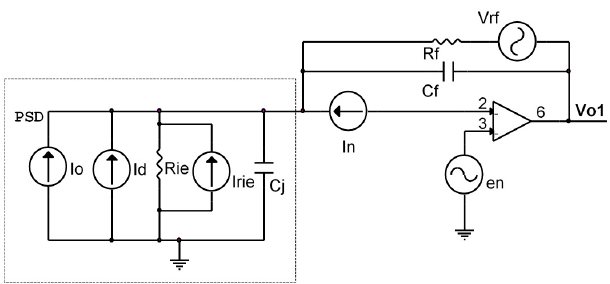
Figure 11. Equivalent PSD sensor circuit and electrical amplification circuit with noise.